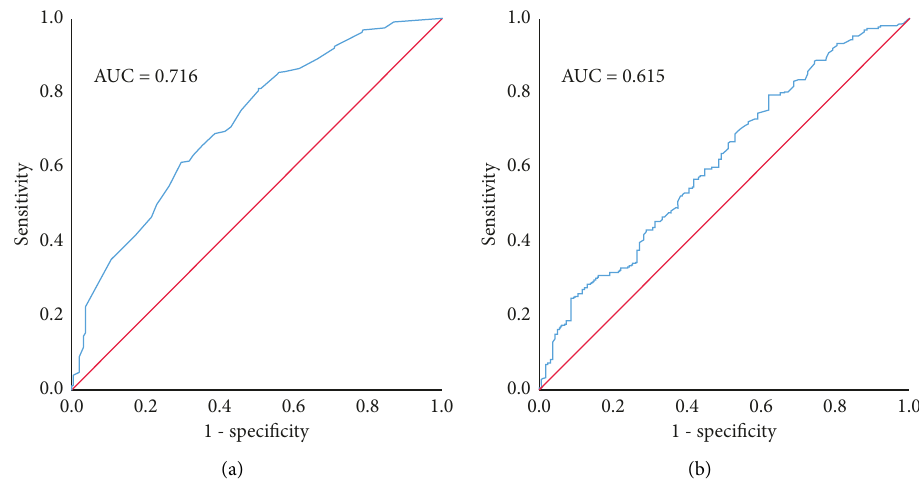
Figure 2: ROC curves for visual outcomes. (a) Baseline BCVA for ≥ 70 ETDRS letters at last follow-up. (b) MH size for VA gain ≥ 15 ETDRS letters between baseline and final